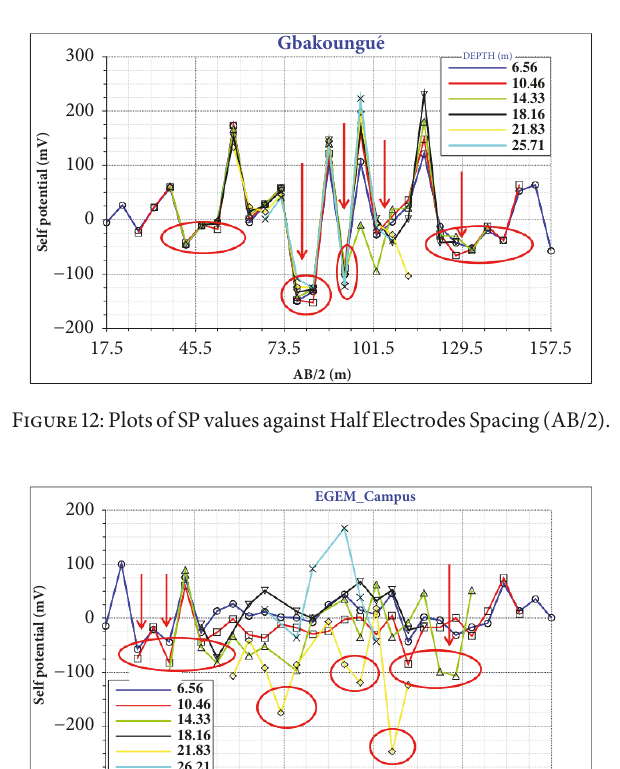
of 99.68 mV, 89.35 mV, and 166.41 mV, respectively. Low SP anomalies are also observed and have been marked by red circle with peaks of -100.81 mV,-106.77 mV,-119.17 mV, -246.74 mV, and -123.61 mV. These low SP anomalies correspond to shallow zone of water infiltration (vertical red arrow lines) while at depth of 21.83 m SP value shows only negative maxima and minima and could be associated with a deeper zone of